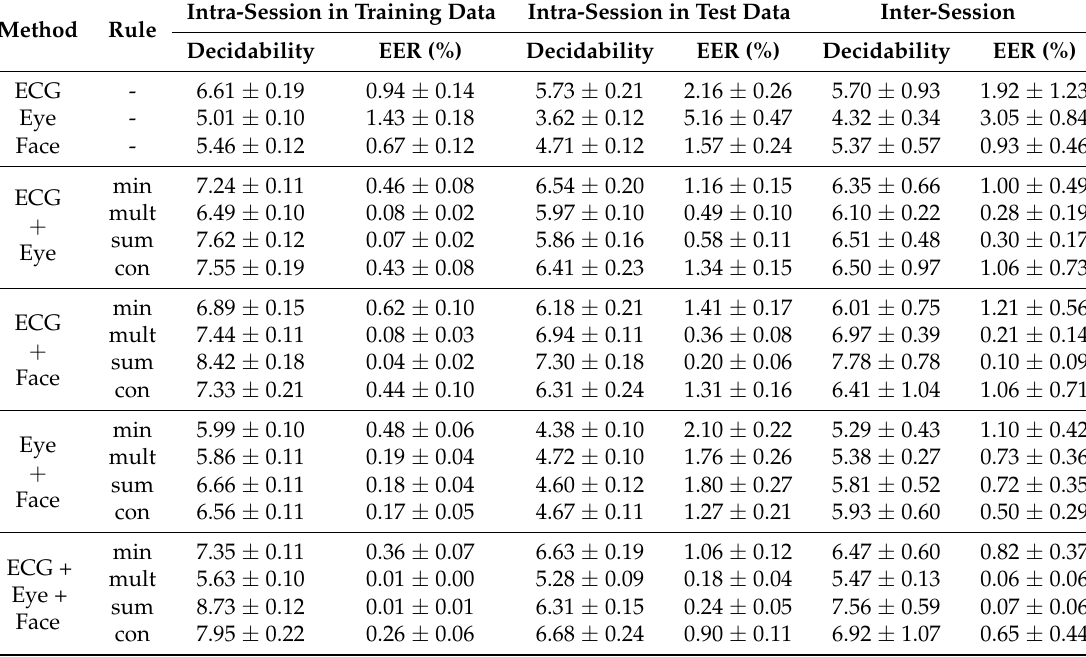
Table 2. Resulting EER and decidability from 30 executions in verification mode of all modalities’ combinations explored by different rules. (con = simple concatenation; min = minimal; mul = multiplication). The best results are highlighted in red. There was no statistical significance among the figures in red; however, they were significantly better than the other